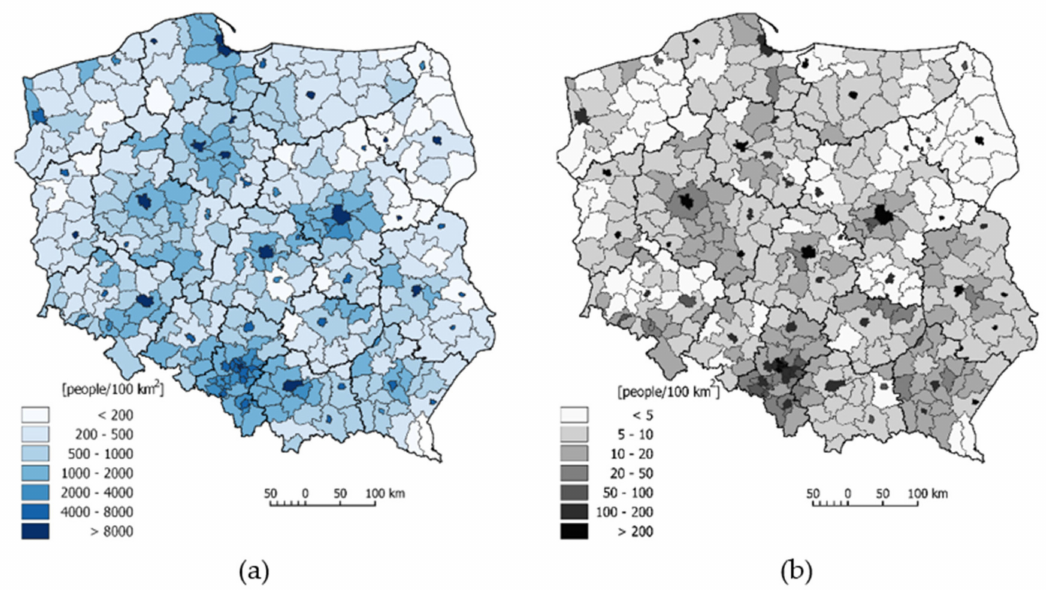
Figure 6. Differences in the values of the following indices of: ( a ) total number of COVID-19 cases; ( b ) total number of COVID-19 deaths in the counties of Poland.